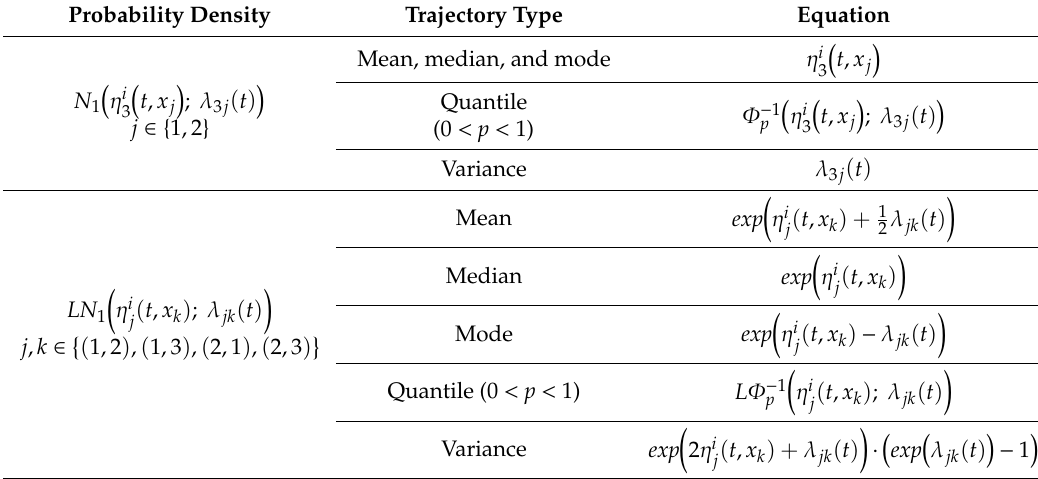
Table 3. Conditional mean, median, mode, p -quantile (0 < p < 1), and variance trajectories with one predictor.